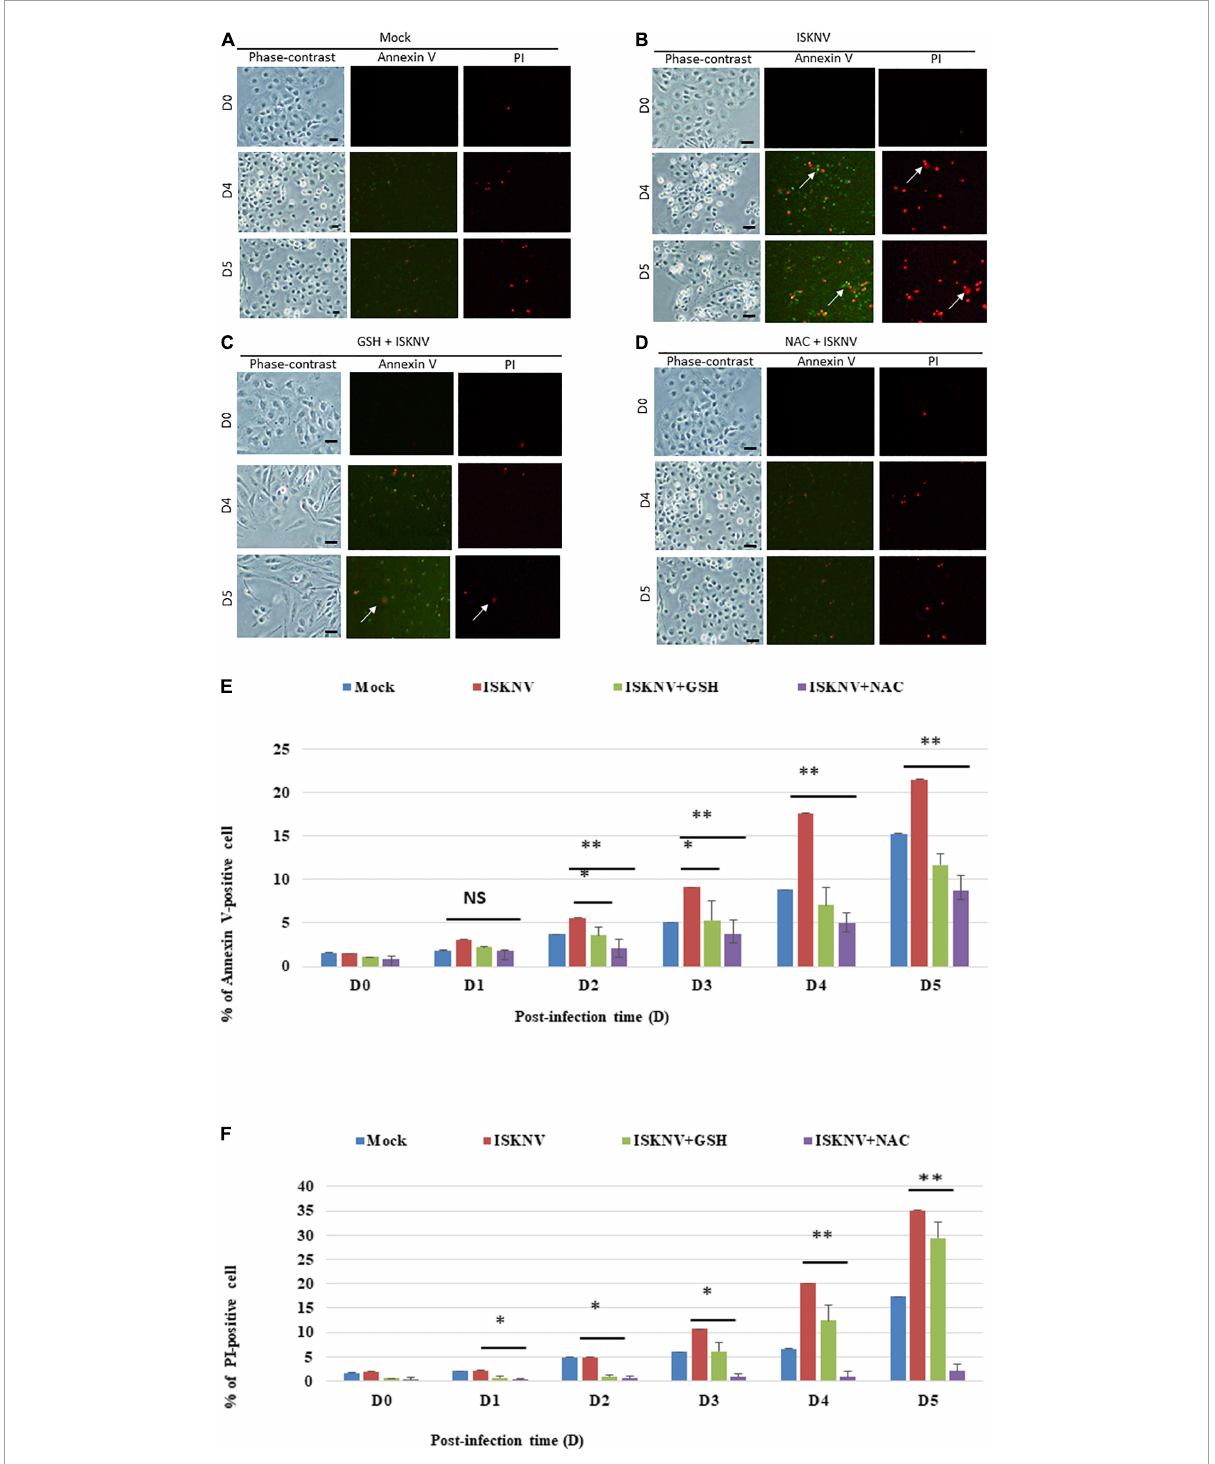
FIGURE4 Glutathione (GSH)- and N -acetylcysteine (NAC)-blocked ISKNV induces apoptotic/necrosis cell death. Cells were labeled using annexin-V/PI staining [ (A–D) : mock-control (A) , ISKNV-infected (B) , GSH-treated and virus-infected (C) , and NAC-treated and virus-infected (D) ]. Phase contrast micrographs of ISKNV-induced apoptotic/necrotic fish cells at day 0, day 4, and day 5. Phase contrast images (left panels: day 0, day 4, and day 5), green fluorescence images for annexin-V-positive cells (middle panels: day 0, day 4, and day 5), and red fluorescence images for necrosis-positive cells (right panels: day 0, day 4, and day 5). Annexin-V-positive cells and necrosis-positive cells are indicated by arrows. (E,F) Percentage of apoptotic (E) /necrotic (F) ISKNV-infected cells at day 0, day 4, and day 5. The quantification of these results was performed for three individual experiments. All data were analyzed using either paired or unpaired Student’s t -tests, as appropriate. ∗ P < 0.01 and ** P < 0.05. ns, no significant